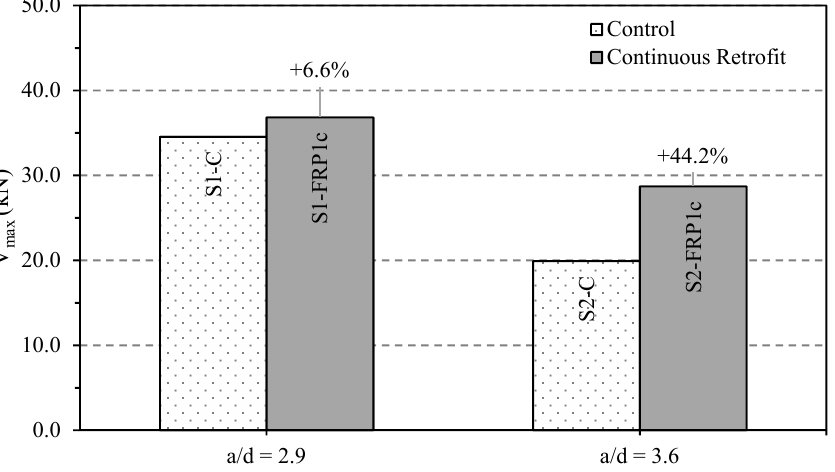
Figure 9. Effect of a / d ratio on shear-strengthening effectiveness.